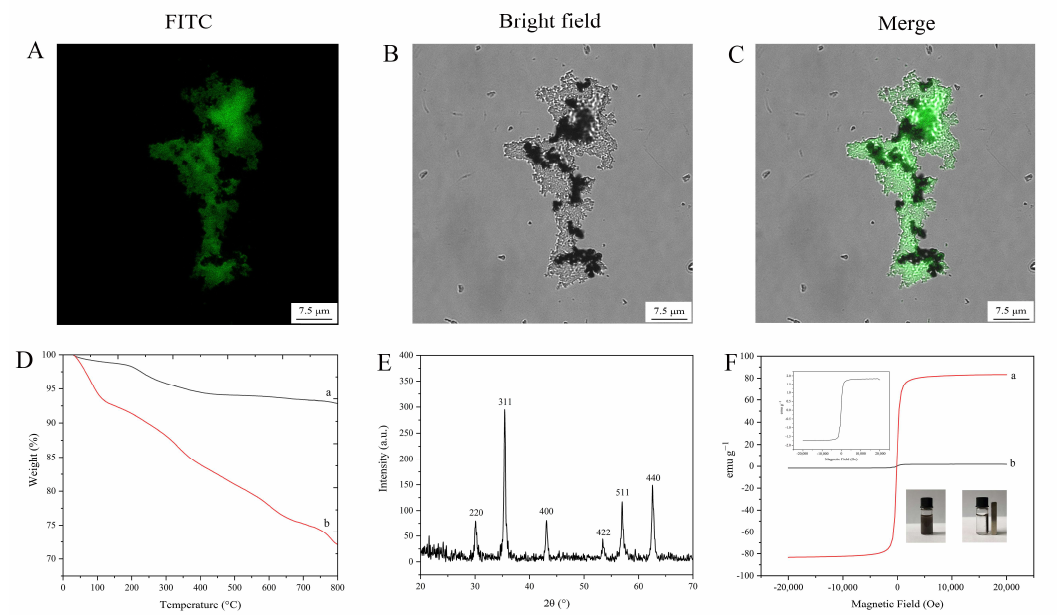
Figure 6. Characterization results: ( A – C ) laser confocal microscopy images; ( D ) TGA curves (a: Fe 3 O 4 , b: encapsulated glucose oxidase); ( E ) X-ray diffraction image; ( F ) magnetic hysteresis regression curves (a: Fe 3 O 4 , b: encapsulated glucose